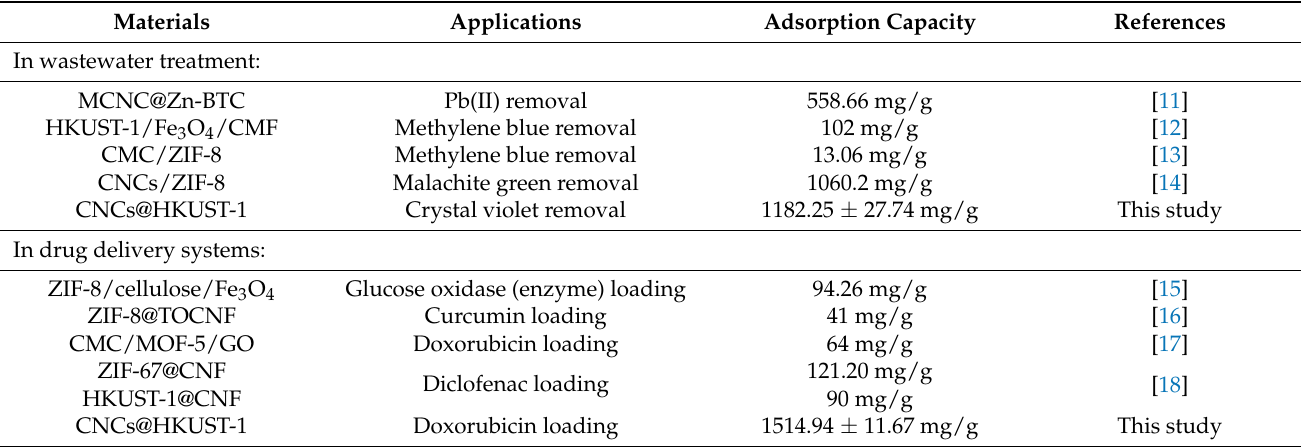
Table 1. Comparison of the utilization of integrated cellulose − based materials in MOFs for wastewa- ter treatment and drug delivery